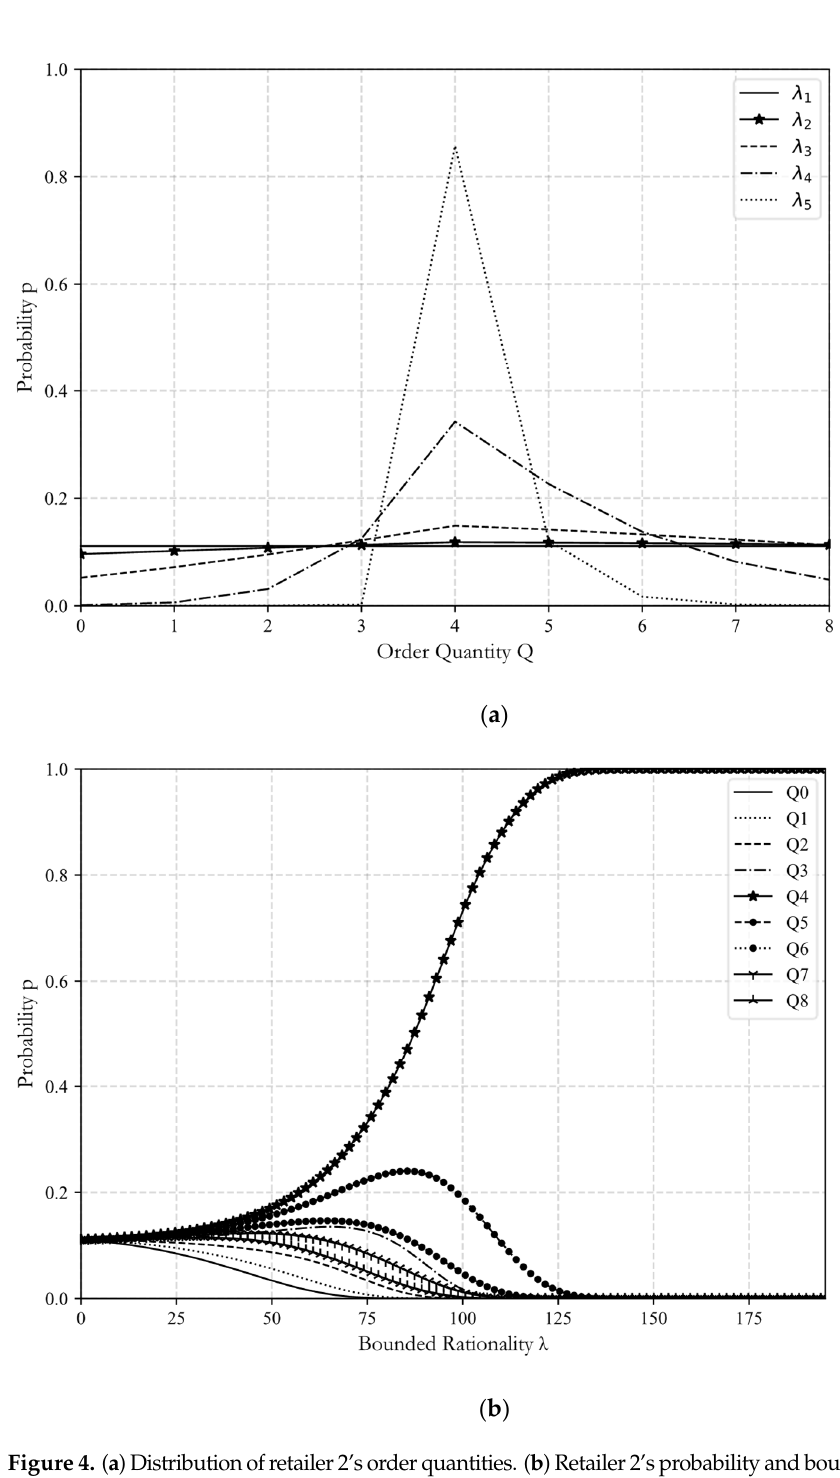
Figure 4. ( a ) Distribution of retailer 2’s order quantities. ( b ) Retailer 2’s probability and bounded